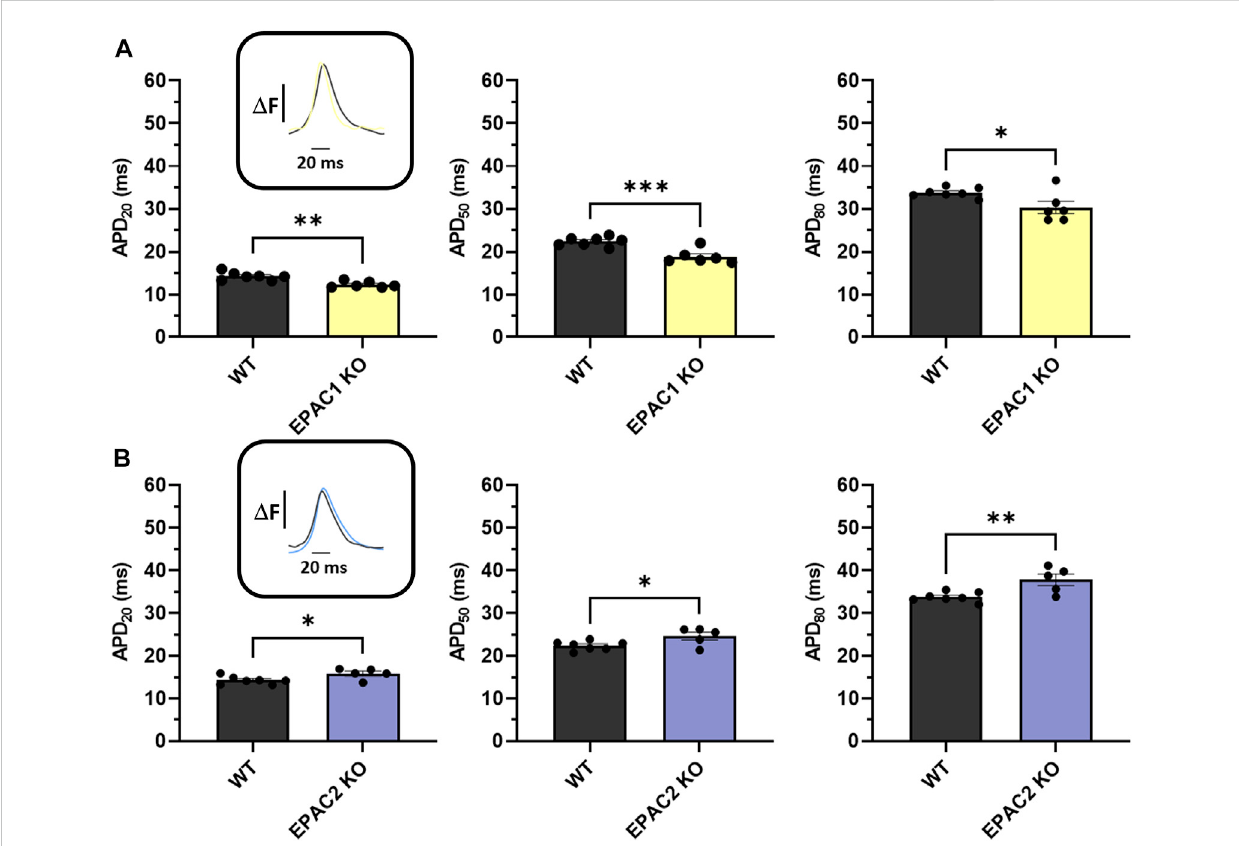
FIGURE 3 Exvivo measurementsofAPDofWTandKOmiceusingopticalmappingduring7 Hzpacing. (A) Means±SEMofAPDfromLAandRAsurfacesonWT ( N = 7) and EPAC1 KO mice ( N = 6). (B) Means ± SEM of APD from LA and RA surfaces on WT and EPAC2 KO mice ( N = 5). Statistical differences were determined by unpaired t-tests (* p < 0.05; ** p < 0.01; *** p <